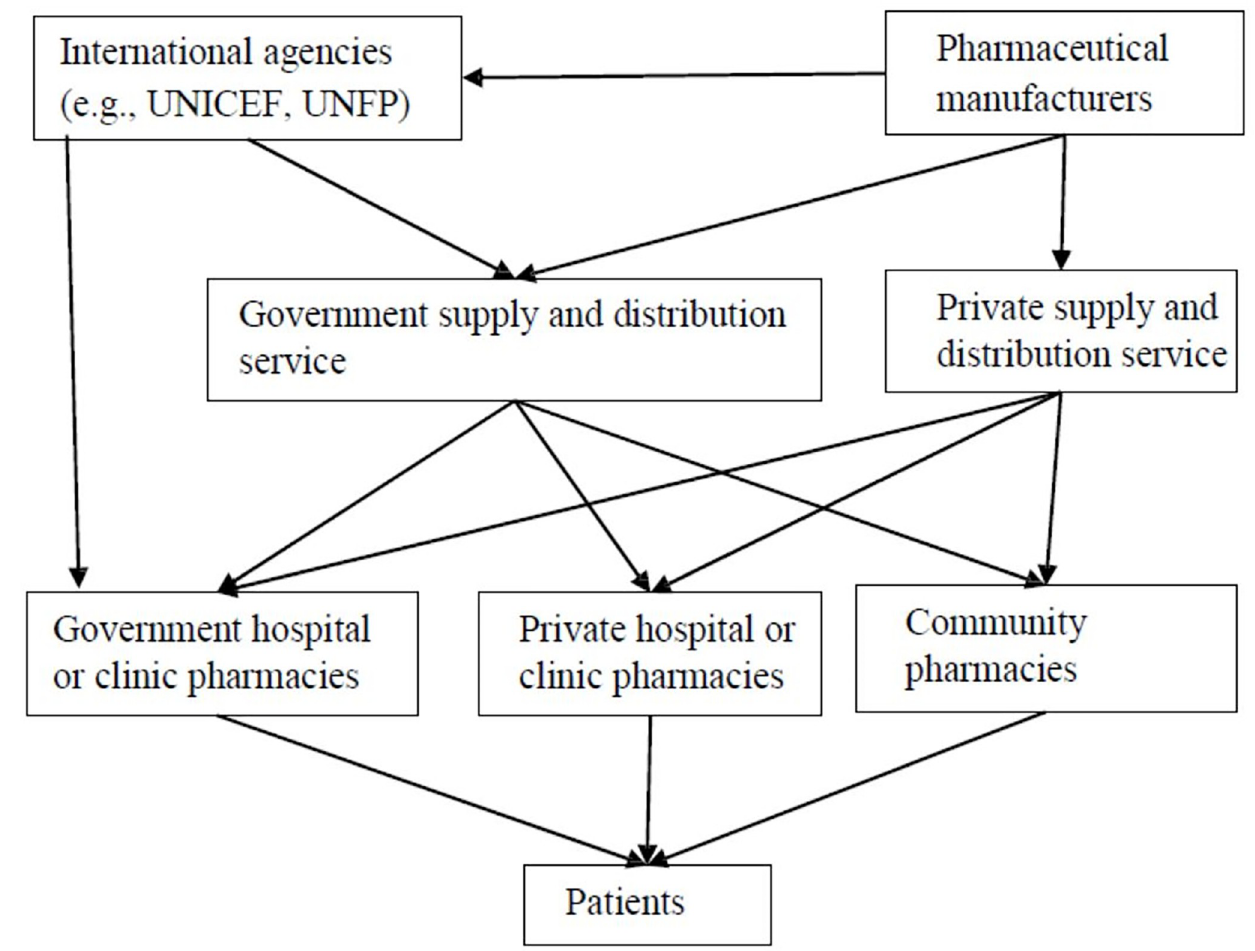
Fig 1. The Ethiopian Pharmaceutical supply and distribution system. Abbreviations: UNICEF: United Nations Children’s Fund, UNFP: United Nations Population Fund.